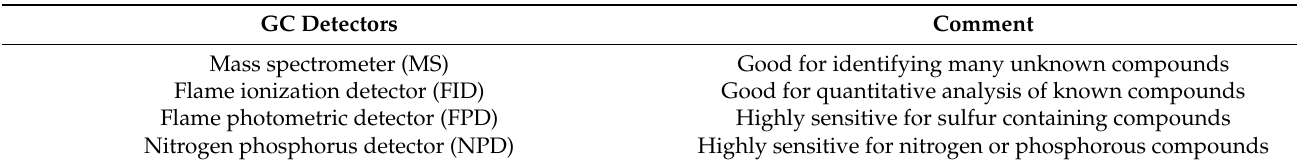
Table 3. Common detectors and uses